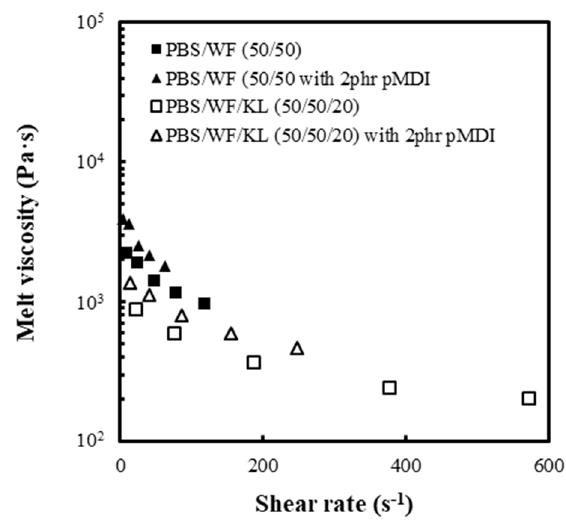
Figure 7. Dependency of the MV of PBS/WF and PBS/WF/KL composites with and without pMDI on the shear rate.